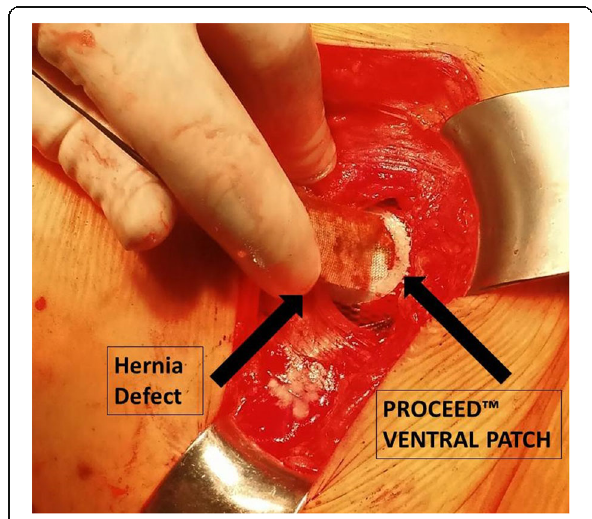
Fig. 4 Surgical repair of the hernia was performed with the patient in a lateral position via a dorsal approach and insertion of a 6.4 × 6.4 cm PROCEED ™ VENTRAL PATCH (Ethicon, Norderstedt,